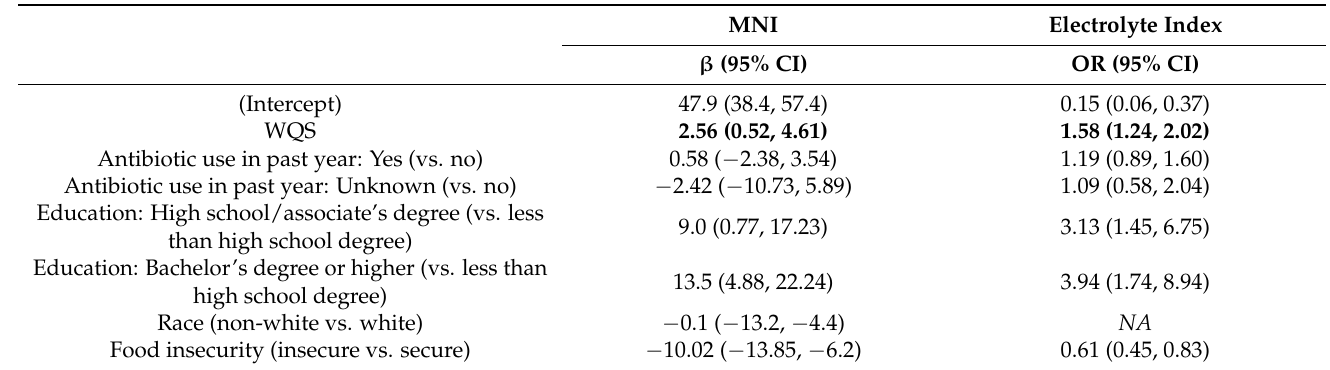
Table 2. Results from the repeated holdout WQSRS regression, with positively constrained betas, for the Gaussian and logit models with non-zero OTUs deciled in generalized linear models and adjusted for covariates. MNI n = 623, Electrolyte index n = 624.